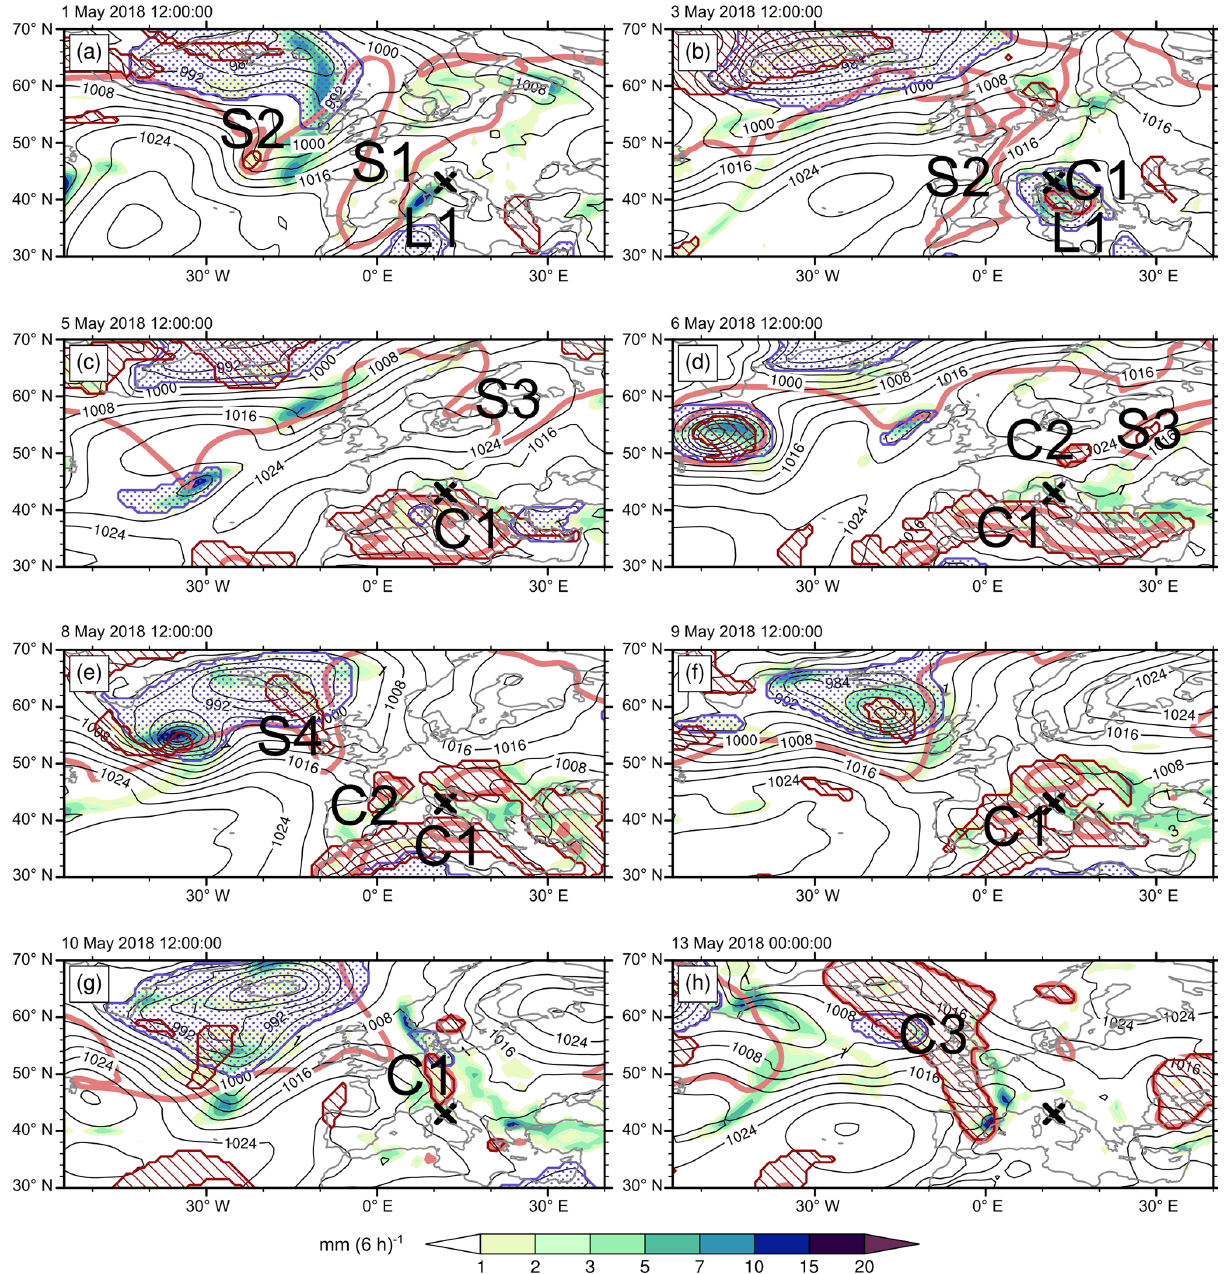
Figure 5. As Fig. 3 but for the longest wet spell at 43 ◦ N, 12 ◦ E in Tuscany, Italy ( S 1 (43 ◦ N, 12 ◦ E)). The light red lines depict 2PVU at 320K. The valid time of each panel is shown in the top